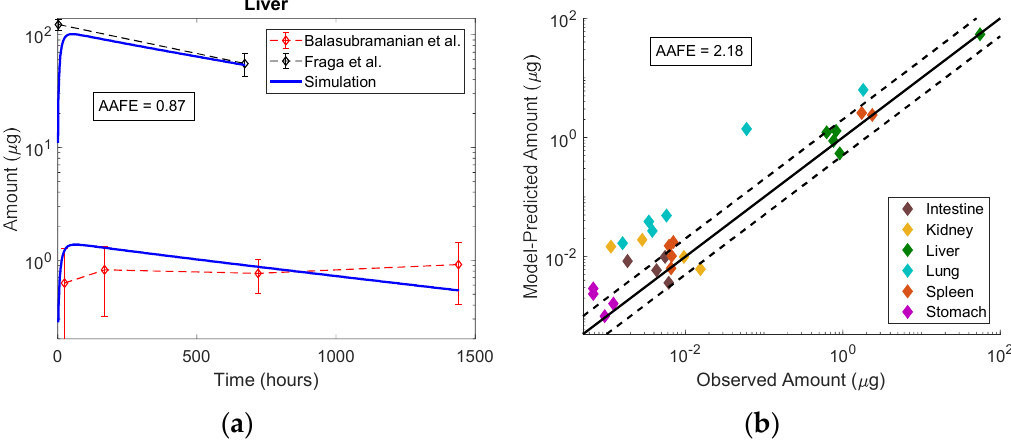
Figure 8. Rat model simulations compared to the observed biodistribution data in rats after IV administration from Balasubramanian et al. [25] and Fraga et al. [26] ( a ) shows the liver profiles and ( b ) shows the model-predicted vs. observed amounts in each organ with relation to the equality line achieving an absolute average fold error of 2.18.